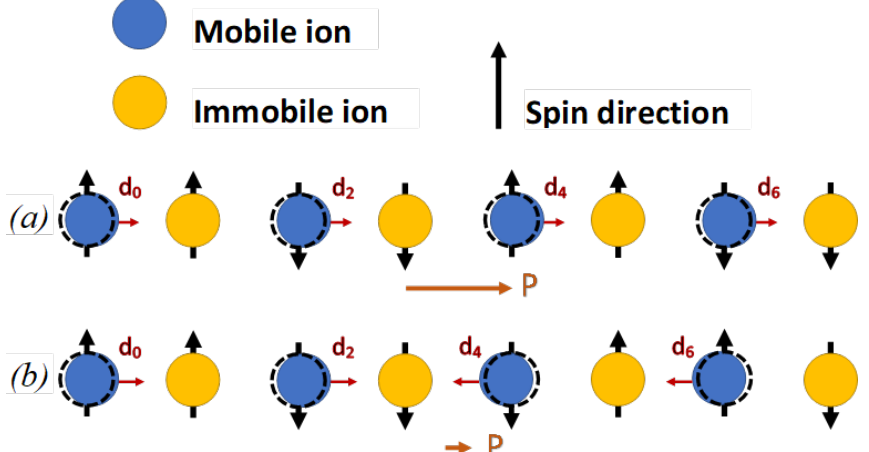
Figure 4. Formation of the electric polarization. Red arrows indicate ion displacements. ( a ) A chain with up–up–down–down ordering. ( b ) A magnetic domain of three spins lined in one direction results in oppositely directed